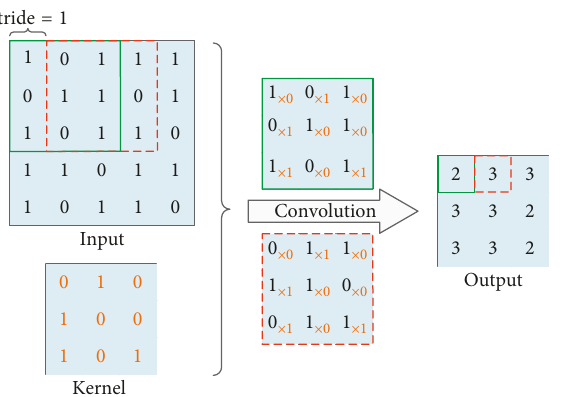
Figure 3: Convolution